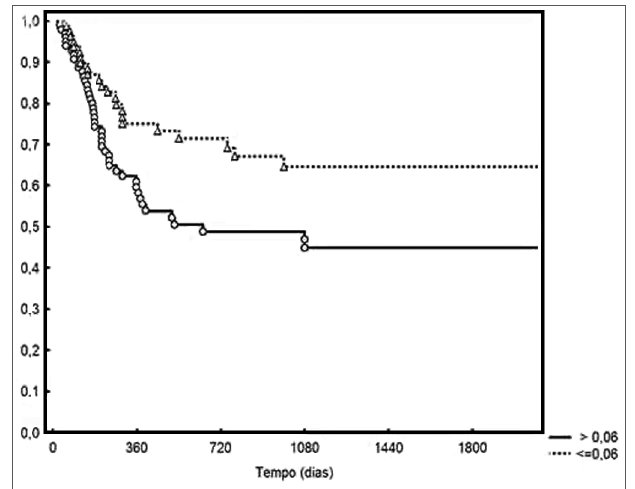
Figura 3. Controle locorregional conforme a densidade linfonodal.